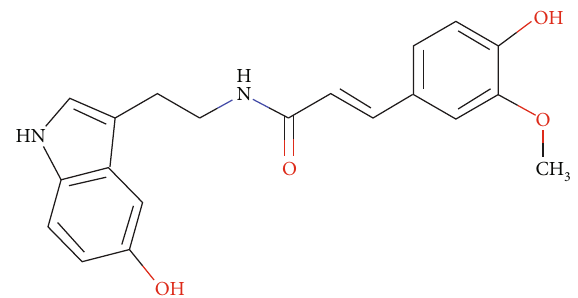
Figure 3: Molecular structure of N -feruloylserotonin (C MW = 352 : 4g/mol